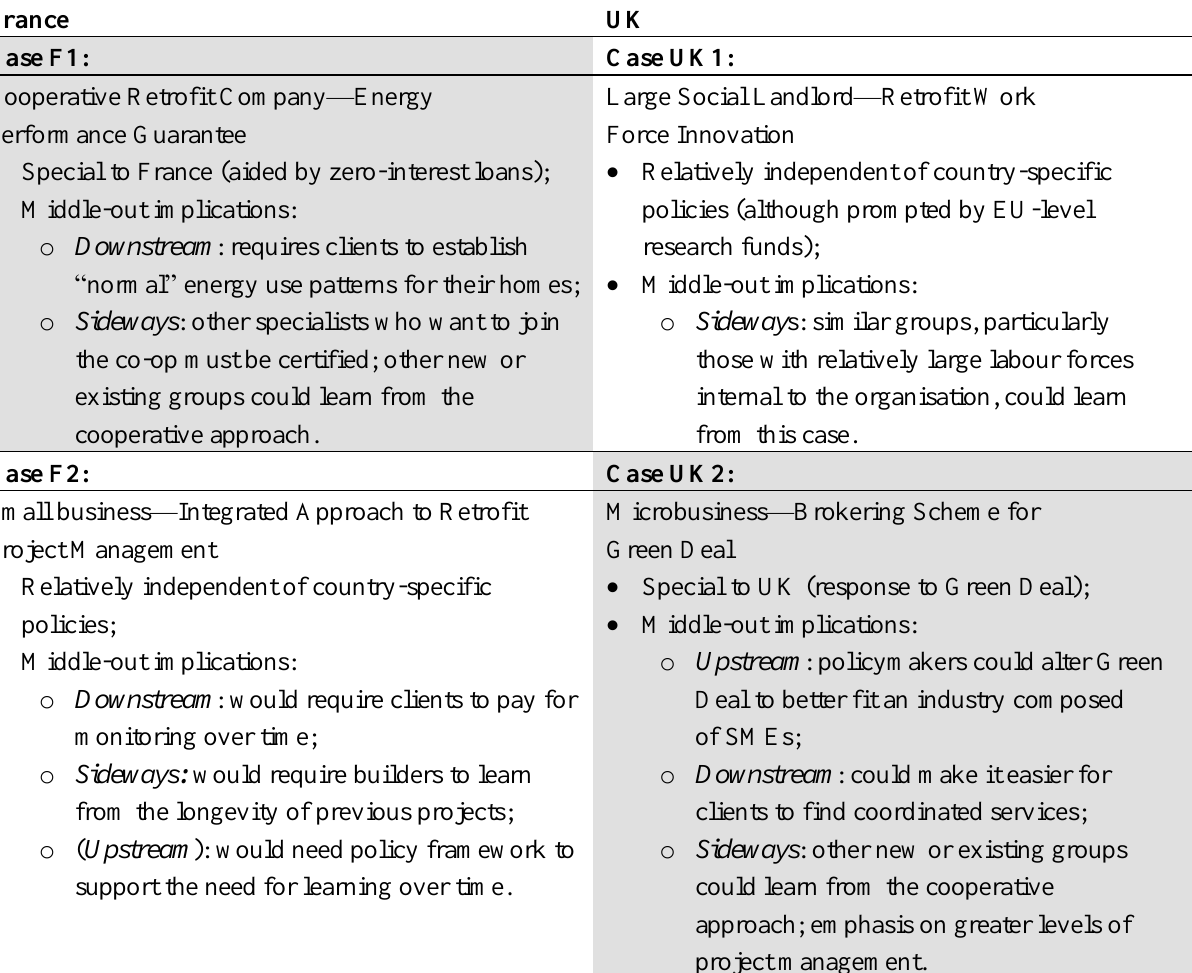
Table 2. Building Expertise Case Studies: Implications of Innovative Businesses Models.